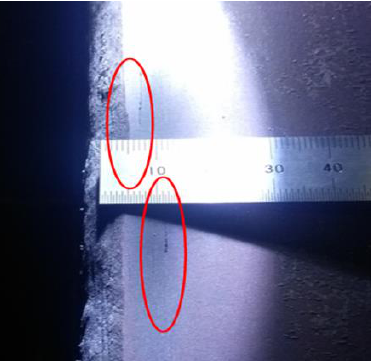
Figure 18. Typical morphology of an edge seam defect on heavy plates produced by the two-chamfered slab under frontal rolling with a two-roller.